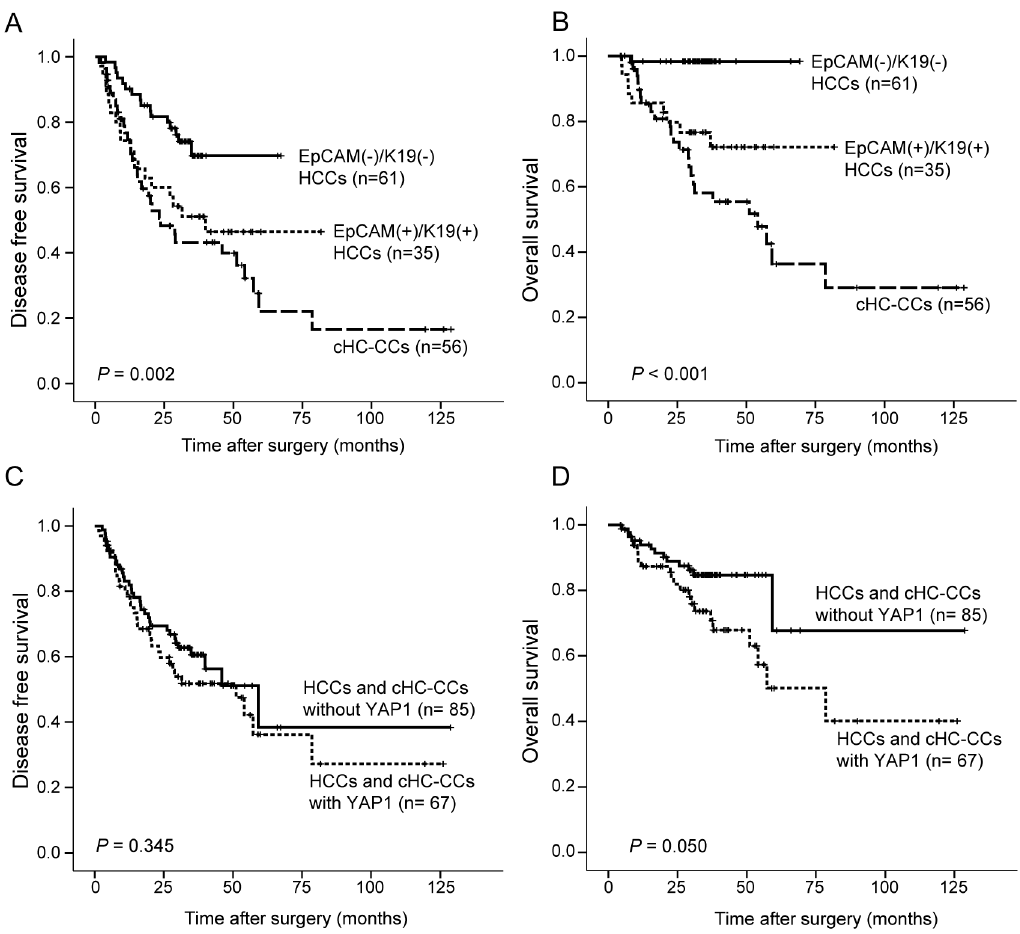
Figure 3. Kaplan–Meier’s plot analysis for disease-free survival and overall survival in HCCs and combined hepatocellular- cholangiocarcinomas (cHC-CCs). Kaplan–Meier’s plot analysis for disease-free survival (A) and overall survival (B) showing a significant difference among EpCAM( 2 )/K19( 2 ) HCCs, EpCAM( + )/K19( + ) HCCs, and cHC-CCs. Overall survival was relatively worse in HCCs and cHC-CCs with YAP1 expression (D), whereas there was no significant difference in disease-free survival between the two